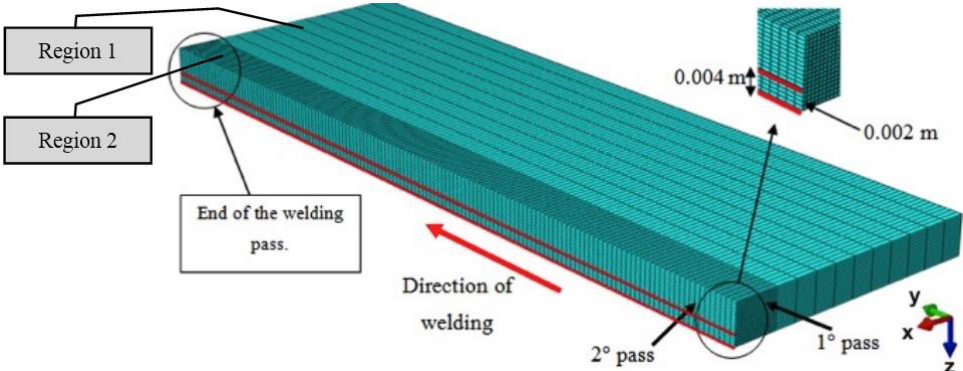
Figure 6. Movement of the welding heat source for the two welding passes. The second pass was initiated when the temperature at the end of the first pass region dropped to 150 °C.